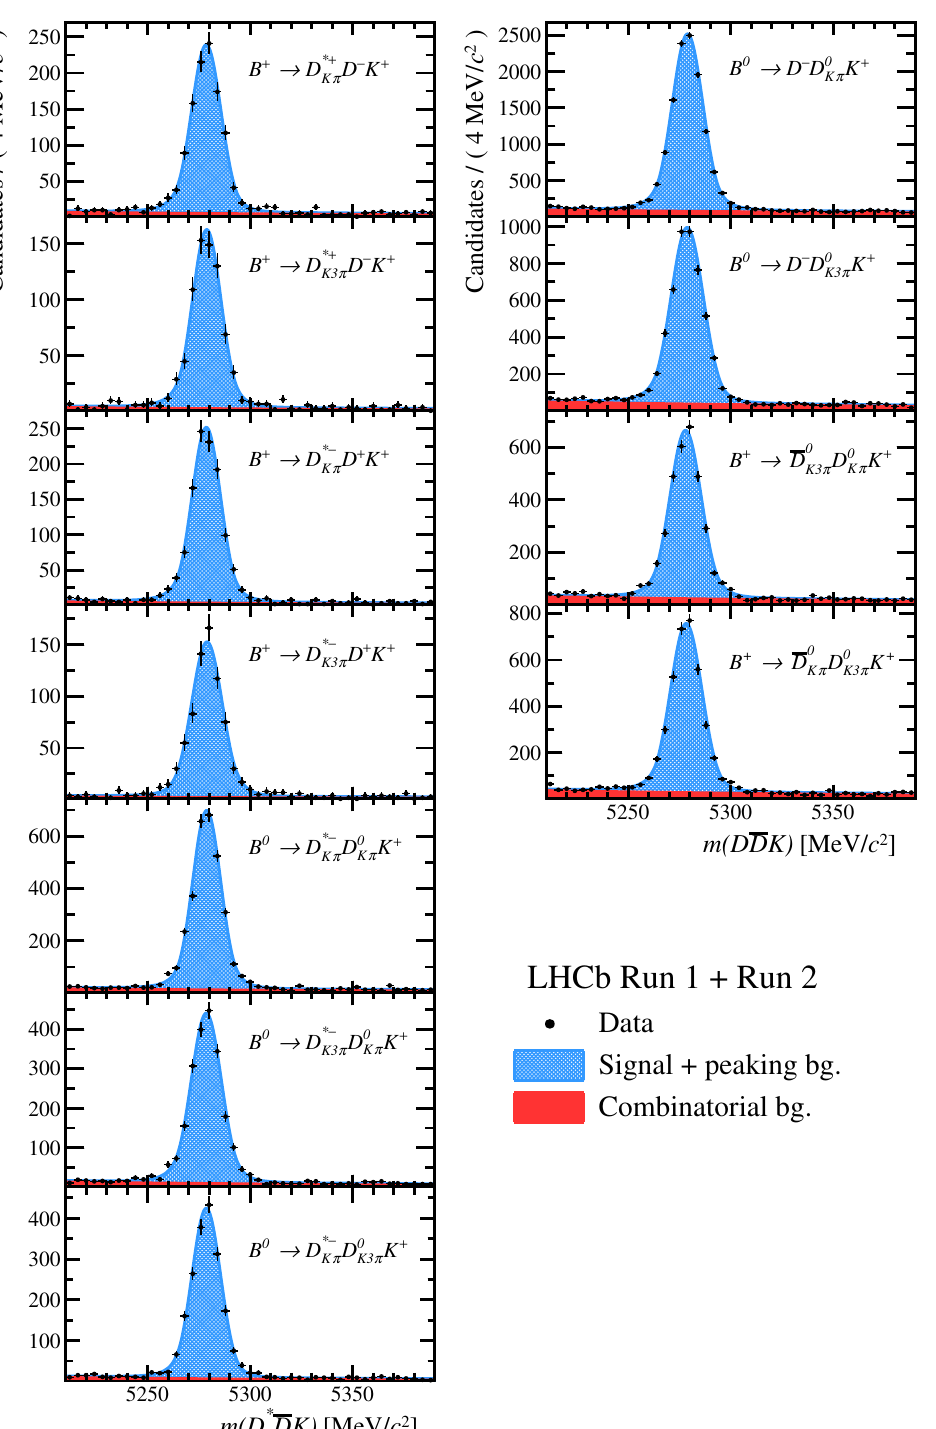
Figure 2 . Fits to the invariant-mass distributions m ( D ( ∗ ) DK ) of (left) B → D ∗ DK and (right) B → DDK for the combined Run 1 and Run 2 samples. The stacked components are (red) combinatorial background and (blue) signal